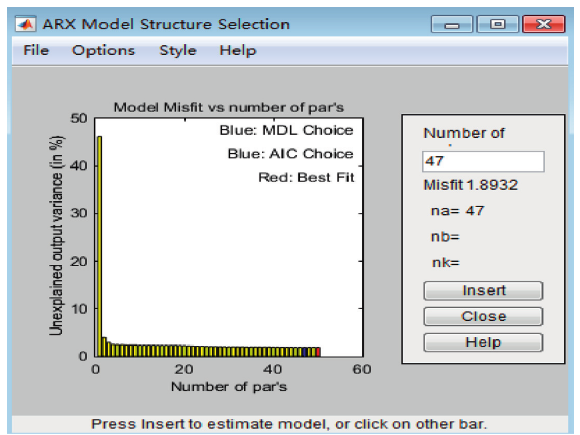
Figure 6: Variation of AIC with model order for node 5 of the undamaged ASCE benchmark structure at 20 ° C.